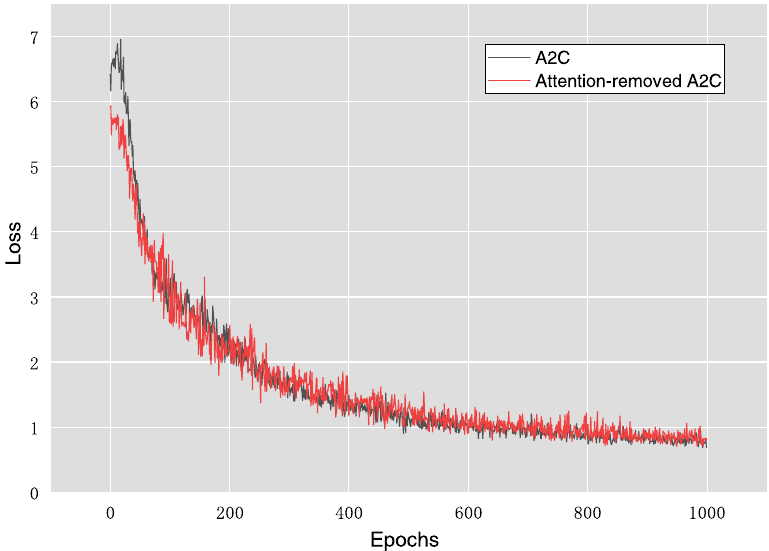
Figure 6. Loss curves of A2C and the attention-removed A2C in the state representation learning